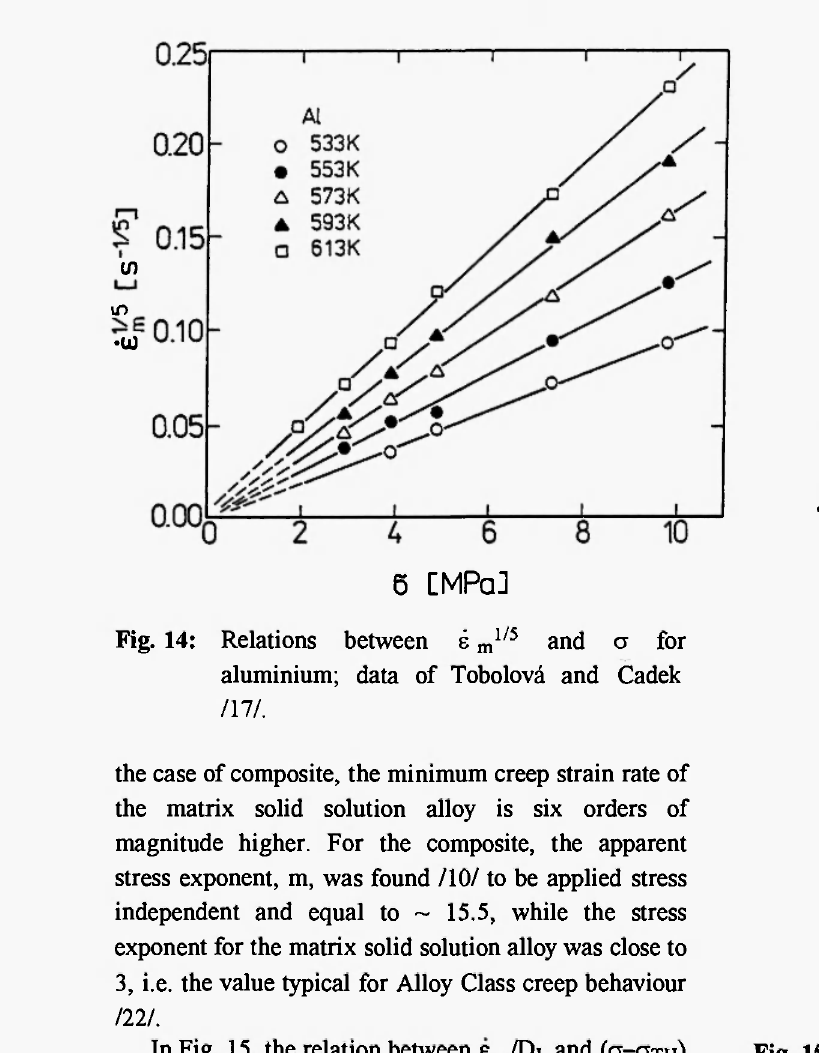
/E>L and (σ-σχπ)^ m